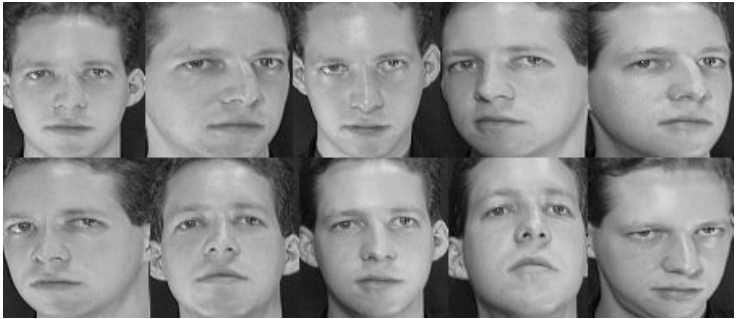
Figure 1. Various face poses for a single person from The AT&T (American Telephone & Telegraph) Face Database. Appl. Sci. 2017 , 7 , 786